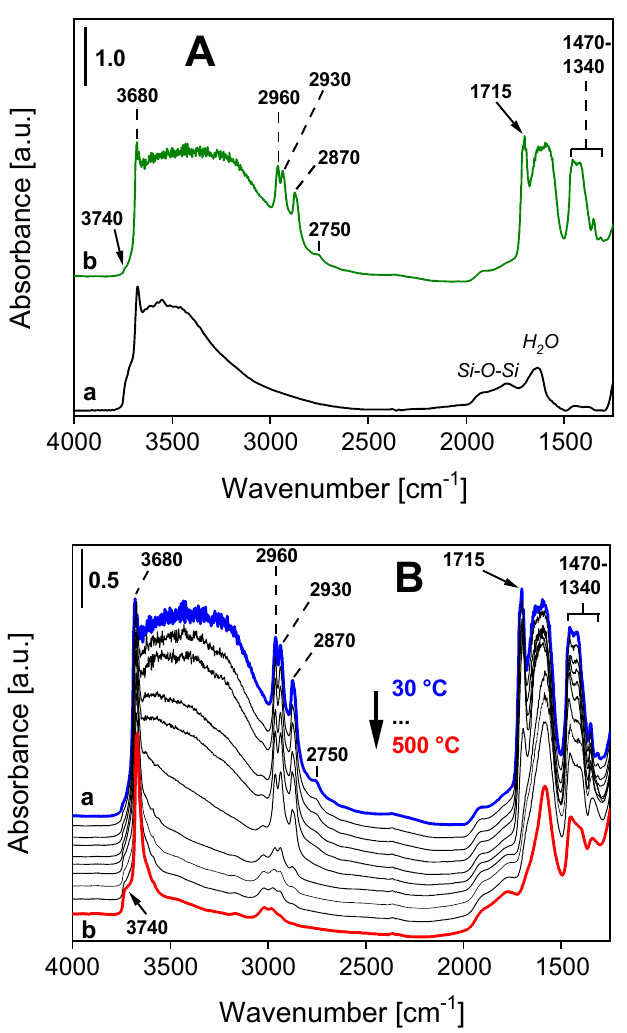
Figure 3. ( A ) FTIR spectra, in the 4000-1250 cm − 1 region, of the Sap (a) and SapC6AN (b) samples, measured in vacuo at room temperature on self-supporting pellets. ( B ) Variable temperature FTIR spectra of the SapC6AN sample, measured in vacuo on a self-supporting pellet, from 30 °C (a) to 500 °C (b).